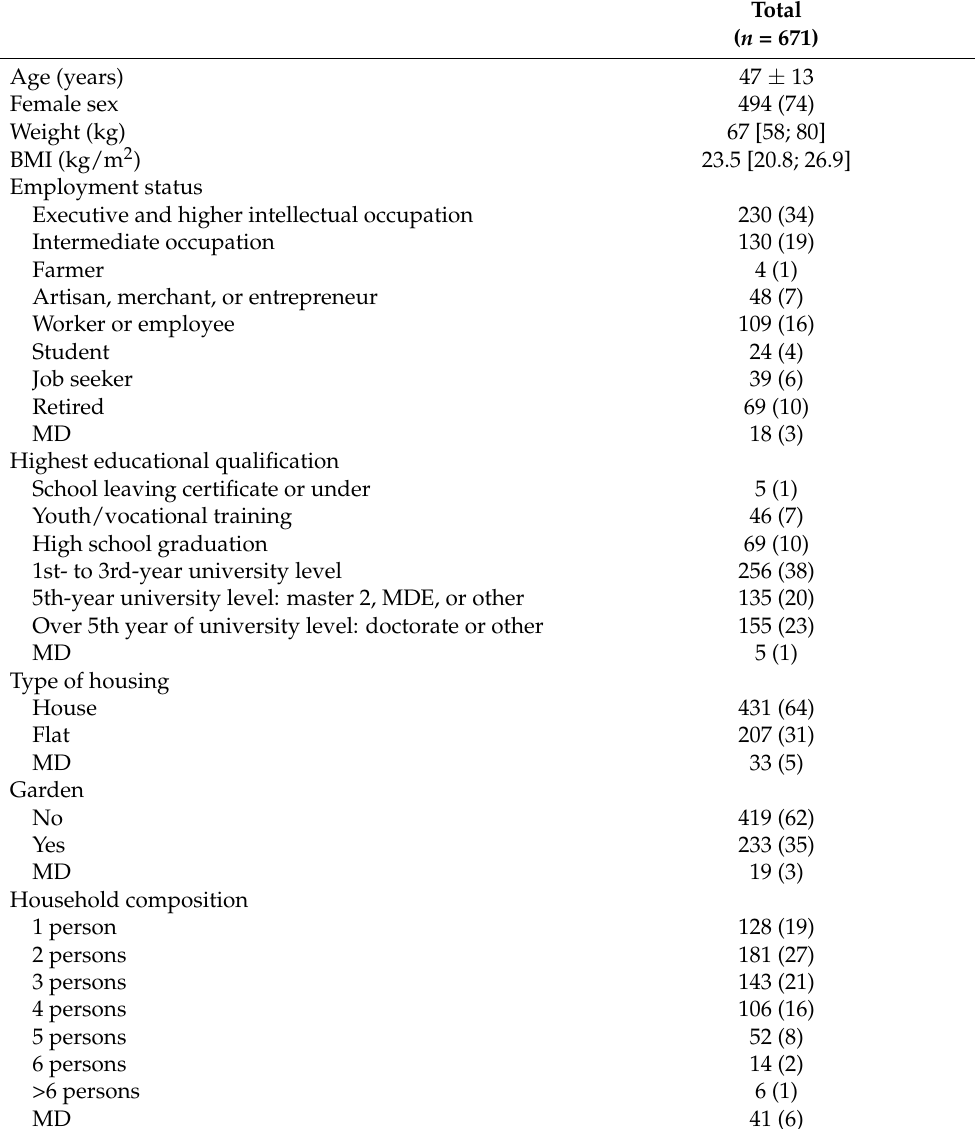
Table 1. Characteristics of the study population ( n =